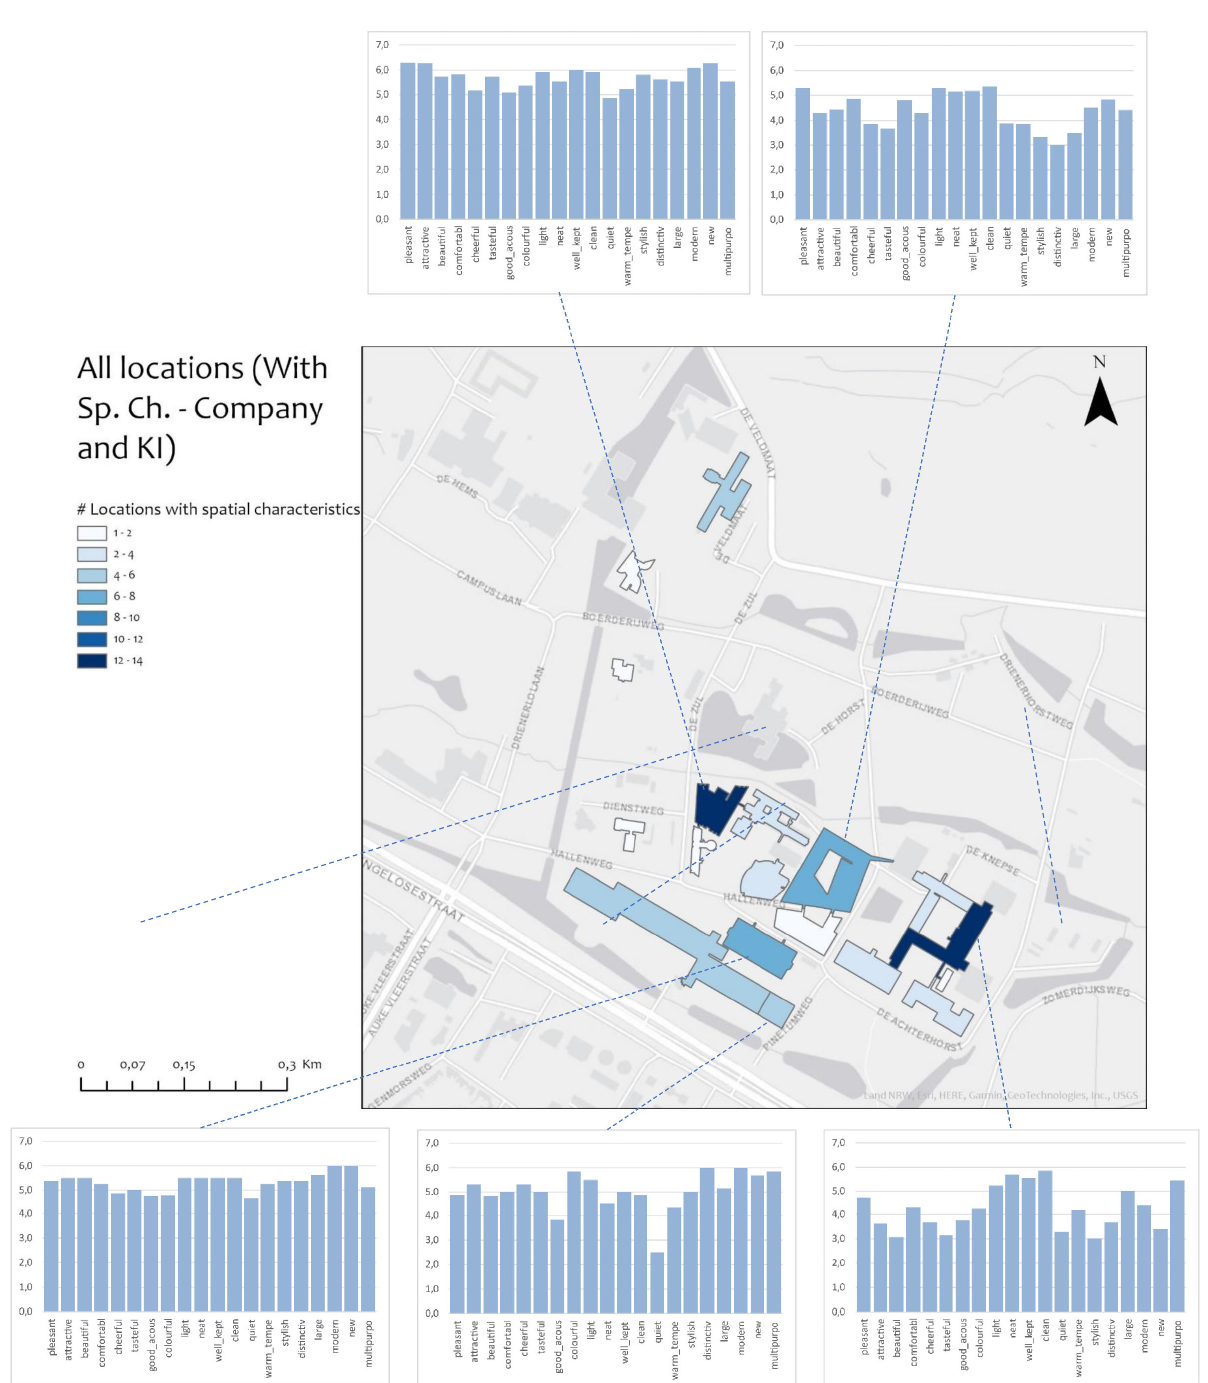
Figure A9. UT campus—average building characteristics’ score for buildings with the highest number of indicated locations. # = ‘Number of’.